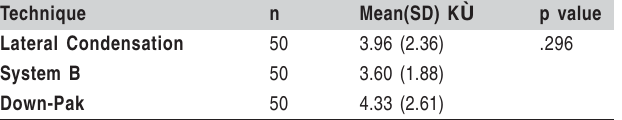
Table 2. Comparison of microleakage values (one-way